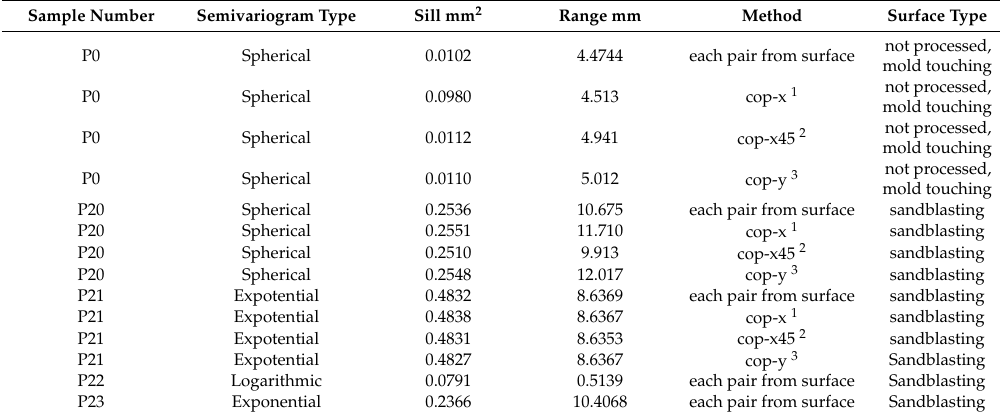
Table 5. Semivariogam fitting results.